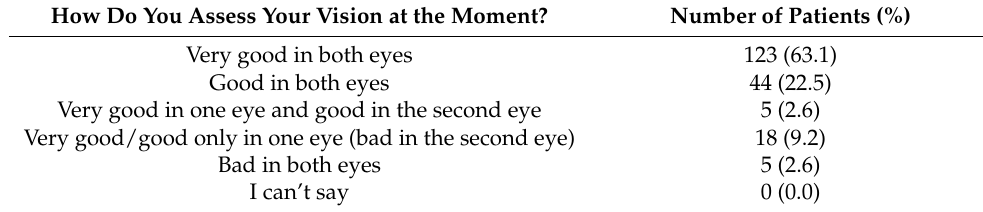
Table 2. Patients’ subjective opinions about their bilateral eyesight after immediate sequential bilateral cataract surgery.